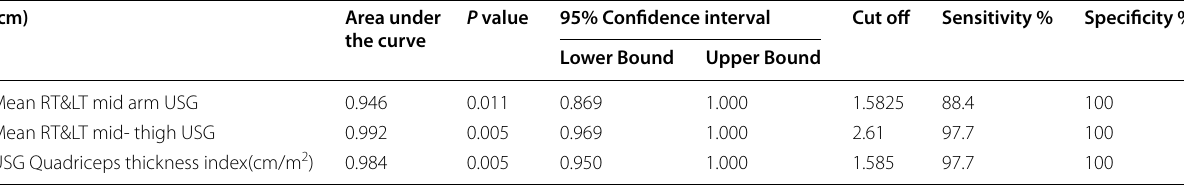
Table 9 Cut off values for female muscle layer thickness (cm)